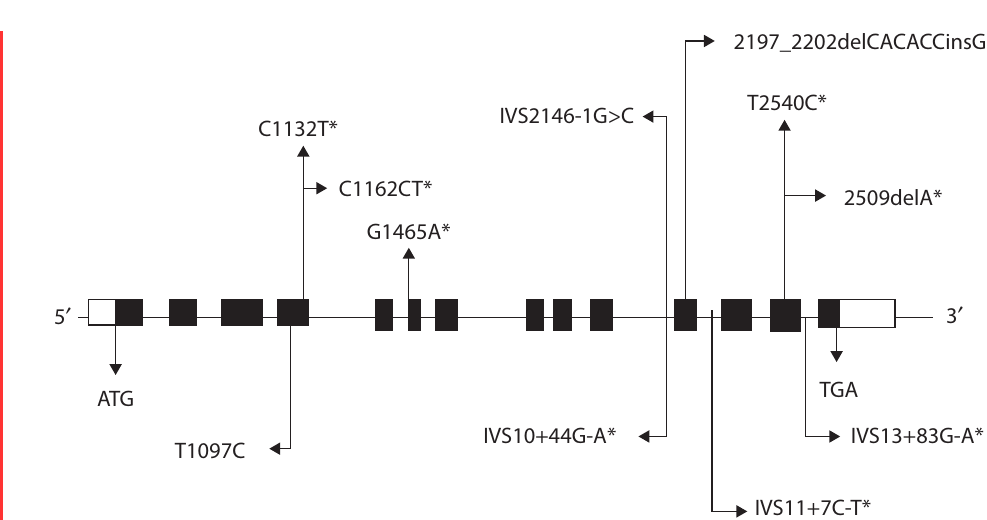
Figure 7. Results from the South African registry; Schematic representation of the PKP2 mutations found in the study. Black boxes indicate the 14 exons of the PKP2 gene. Disease causing mutations are shown above the exons and polymorphisms are shown below [34].